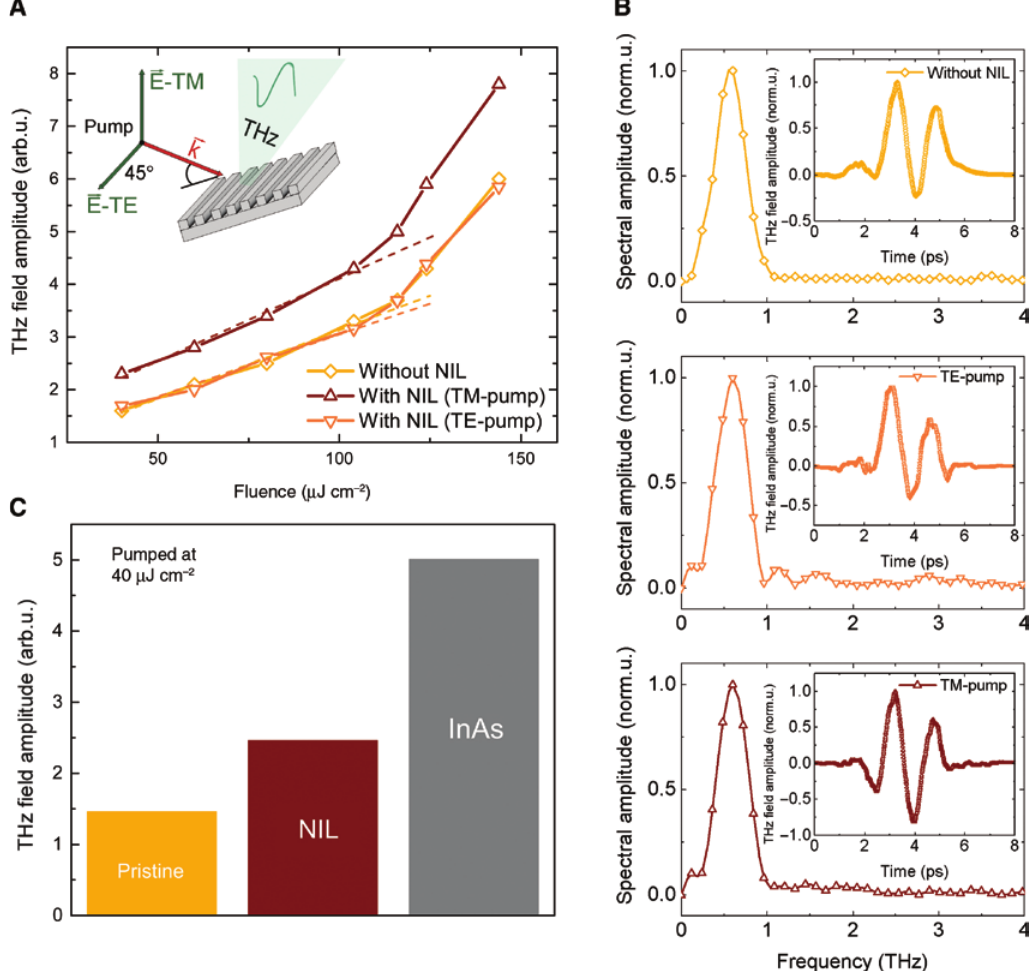
Figure 2: THz measurement results. (A) Experimentally measured dependence of THz amplitude from smooth (yellow line) and nanoimprinted (NIL, brown and orange lines) MAPbI films on fluence of femtosecond laser pump. (B) Spectra of the THz pulse generated from the MAPbI 3 where the curve colors are similar to those on picture (A). (C) Comparison of THz field amplitude from smooth and nanostructured perovskite films with a commercial InAs